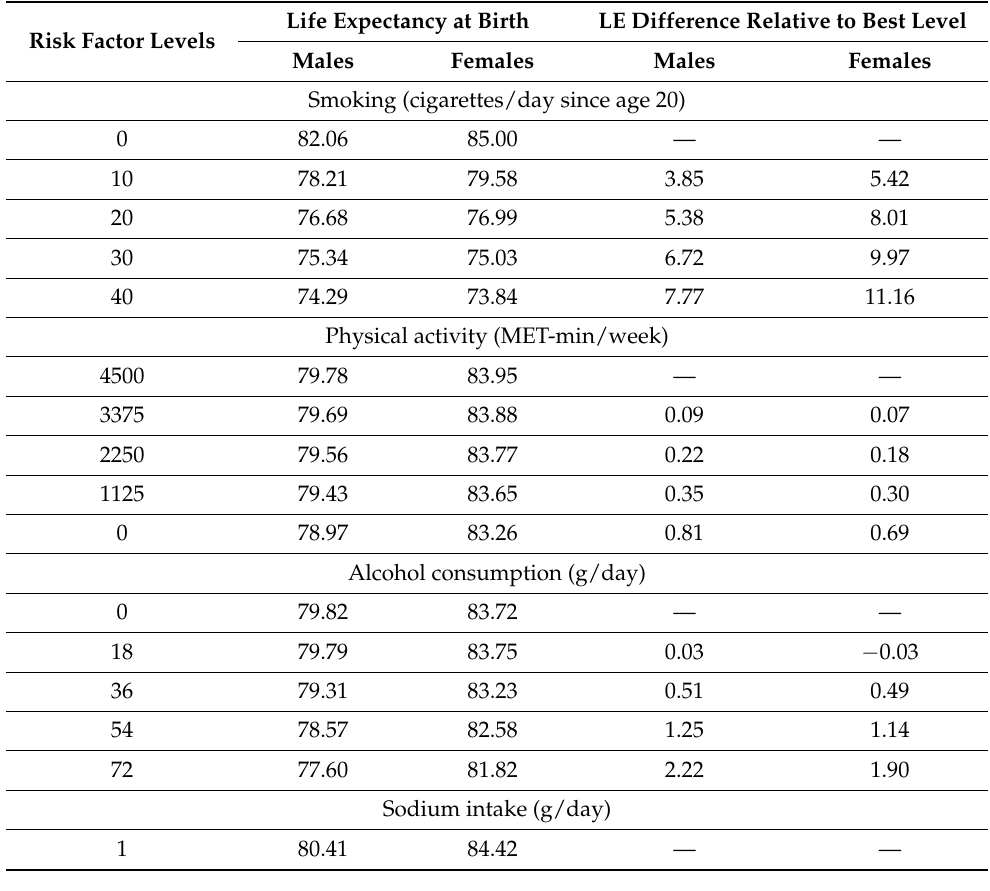
Table 2. Life expectancy at birth for selected levels of 21 behavioral risk factors and differences relative to optimal